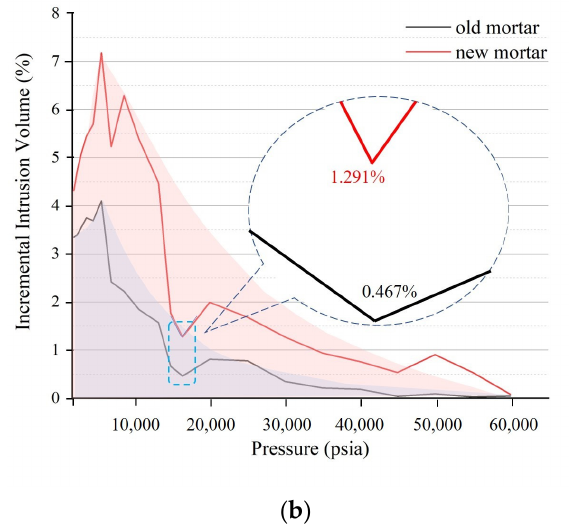
Figure 3. Trend of increasing pressure and intrusion of OM and NM: ( a ) early stage of MIP process; ( b ) end stage of MIP process.